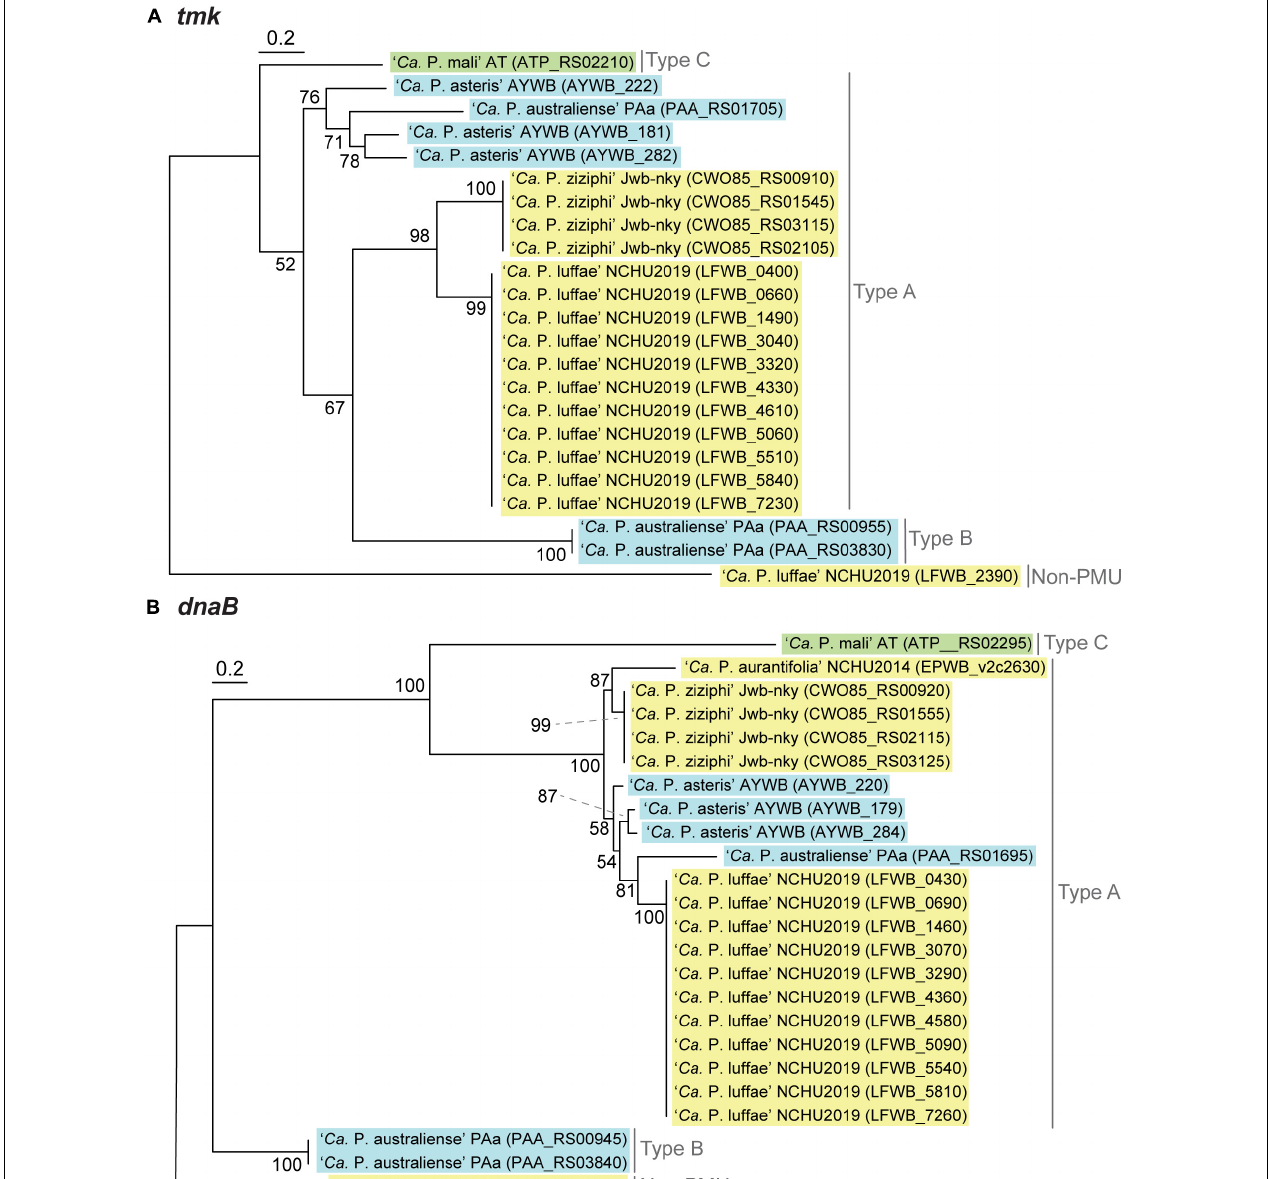
FIGURE 6 | Maximum likelihood phylogenies of PMU core genes (A) tmk (228 aligned amino acid sites). (B) dnaB (531 aligned amino acid sites). In both panels, a non-PMU homolog is included as the outgroup. Numbers next to internal branches indicate the bootstrap support levels based on 1,000 re-sampling. Background colors for the gene identifiers indicate the three phylogenetic clusters of phytoplasmas (I: blue; II; green; III: